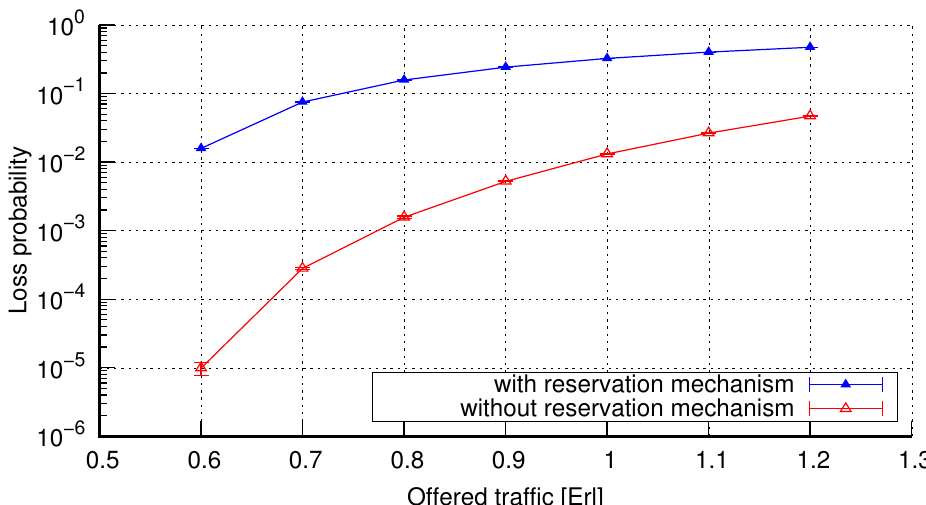
Figure 12. Loss probability for calls of class 2 (non-privileged class) in System 2.